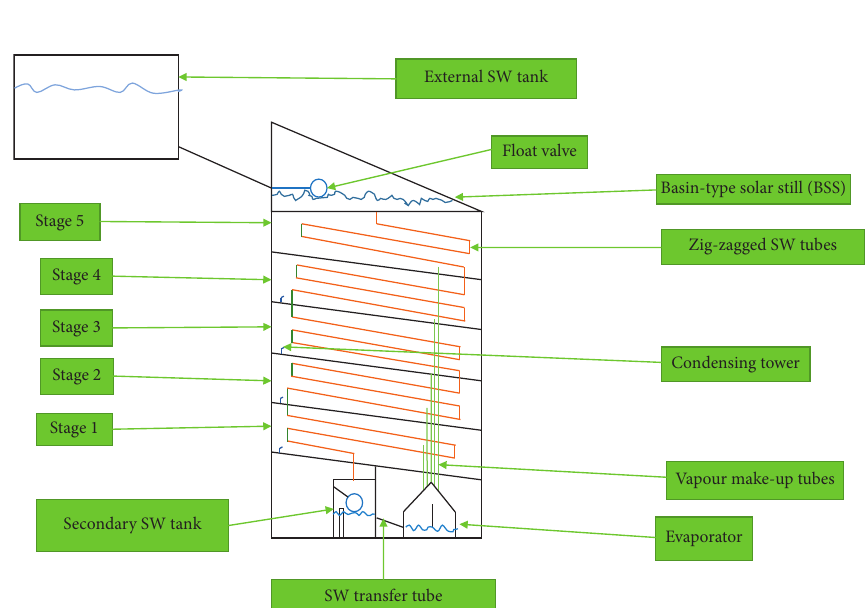
Figure 1: Waterbed-based